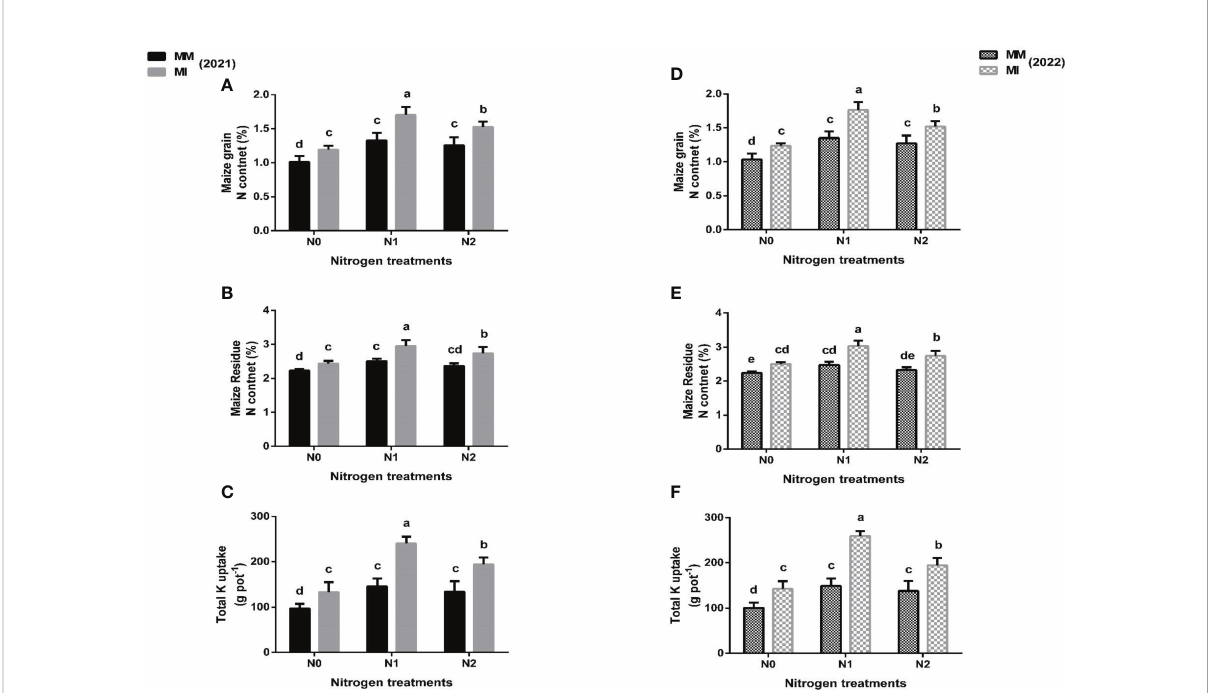
FIGURE 3 Maize grain N content (A, D) , residue N content (B, E) ; total N uptake (C, F) under different planting patterns (MM, maize mono-cropping and MI, maize intercropping) and N fertilizer application rates (N 0 ; 0 kg N ha -1 , N 1 ; 250 kg N ha -1 and N 2 ; 300 kg N ha -1 ) in 2021 and 2022 crop growing seasons. The column bars with dissimilar lowercase letters are signi fi cantly different from each other as per the LSD test ( p <